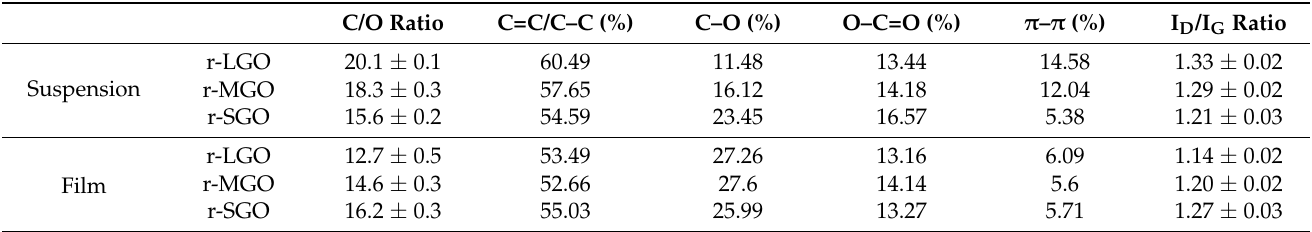
Table 2. Summary of XPS and Raman spectra analysis of rGO samples prepared with different size GO in suspension and film. Error bars represent standard error of mean (SEM), n =